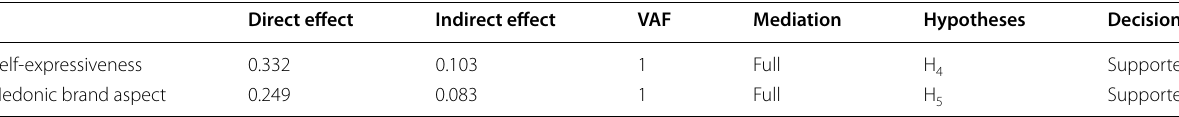
Table 7 Mediation analysis